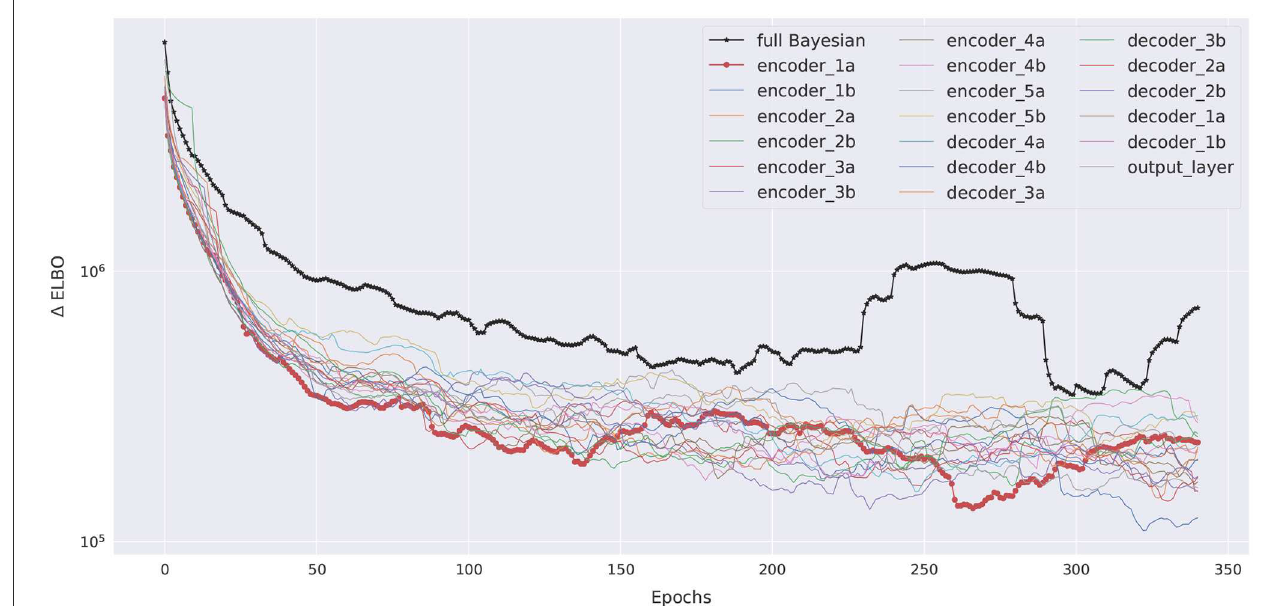
FIGURE7 1 ELBO training history for all models.